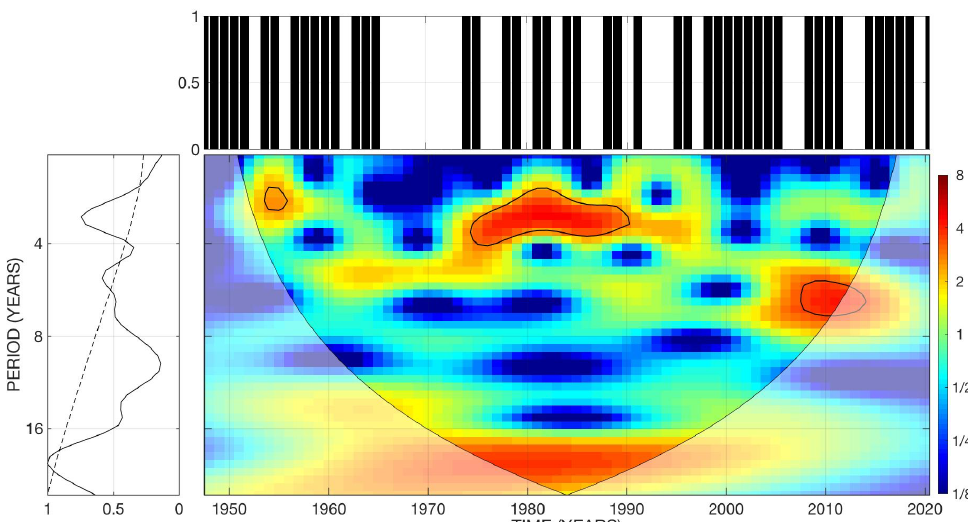
Figure 3. Time-frequency wavelet results of category 4 Atlantic hurricanes between 1950 and 2021. The digital time series for category 4 Atlantic hurricanes is shown in the upper panel. The global wavelet spectrum is shown in the left panel. The central panel shows the calculated wavelet Power Spectral Density (PSD) in normalized units adopting the red-green-blue color scales. The Cone Of Influence (COI, “U”-shaped curve with shaded outer zones) shows the possible edge effects in the PSD. The time-frequency regions with wavelet spectral power detection above 95% confidence level are marked with thin black contours.